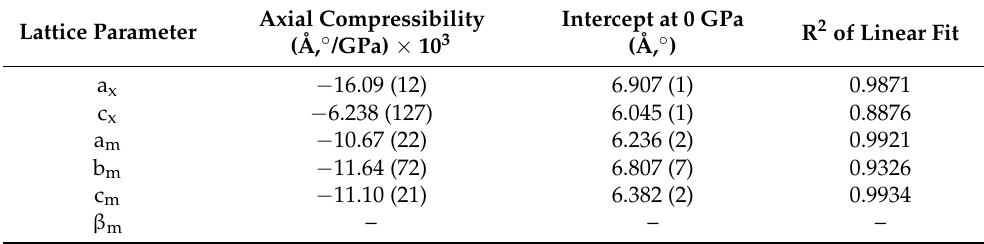
Table 1. DyPO 4 axial compressibilities derived from linear fits of lattice parameter data at pressures below the hydrostatic limit. Negative values indicate compression.